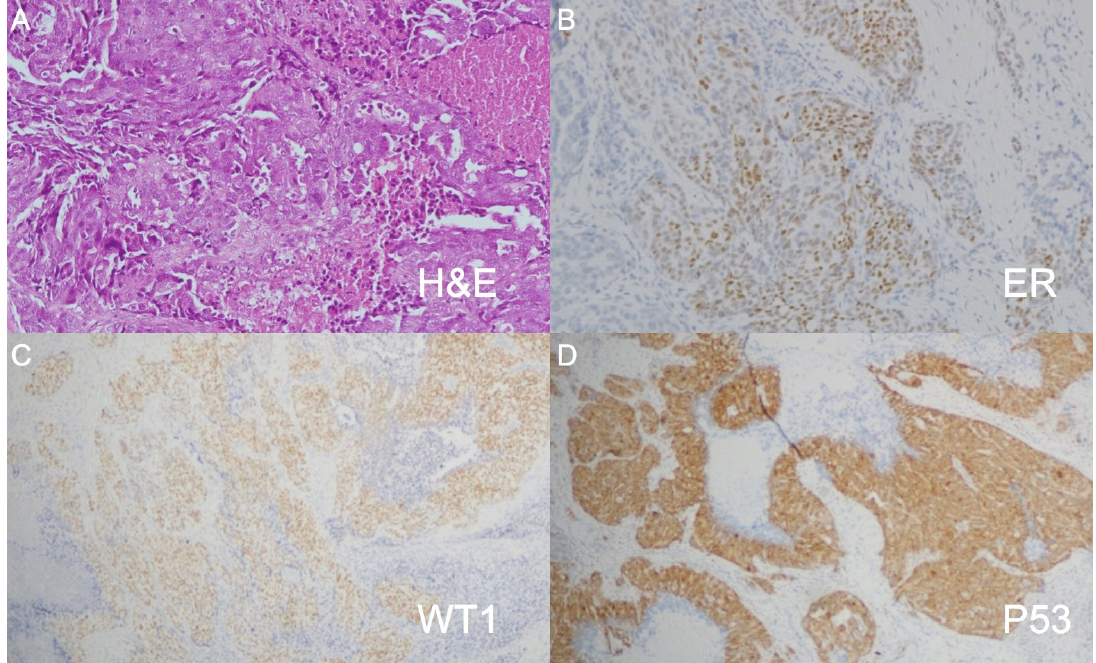
Figure 4. ( A ) The nest of tumor cells displayed papillary and solid patterns and forming labyrinth structure with slit ‐ like space (H&E: hemotoxylin and eosin). (Original magnification ×100); ( B – D ) the tumor cells are focally positive for ER (es ‐ trogen receptor), diffusely positive for WT1 (Wilm’s tumor 1) and P53. (original magnification ×40).